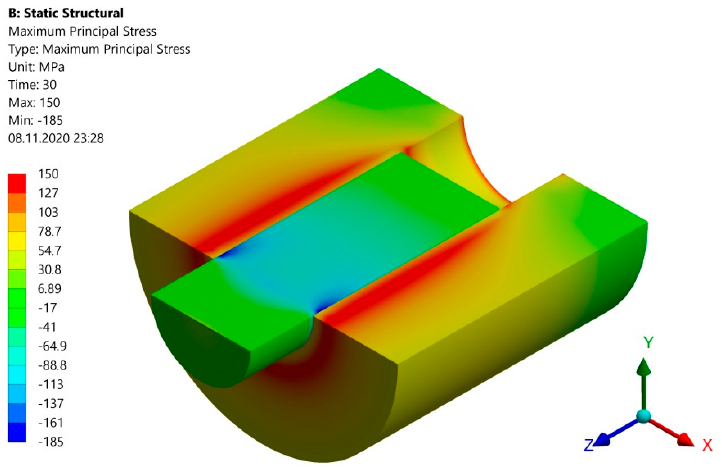
Figure 5. Principal stresses contour-assembly view.